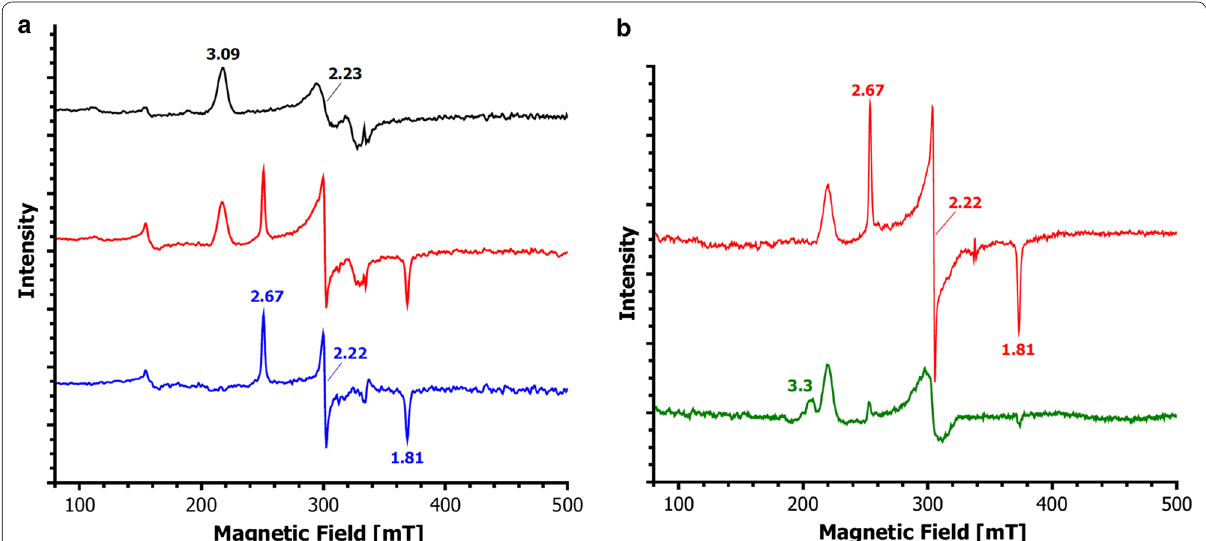
Fig. 2 EPR-spectra of RoxA-F317Y as isolated compared to RoxA-Wt. a The difference spectrum (blue) of F317Y (red) minus the RoxA-Wt-spectrum (black) displays additional EPR-intensity representing a characteristic haem–O–Tyr coordinated low - spin species. b EPR-spectra of RoxA-F317Y as isolated (red, different preparation as in a ) and after incubation with pyridine (5 mM, 15 min at 4 °C) (green) resulting in almost total replacement of the Tyr-ligation by